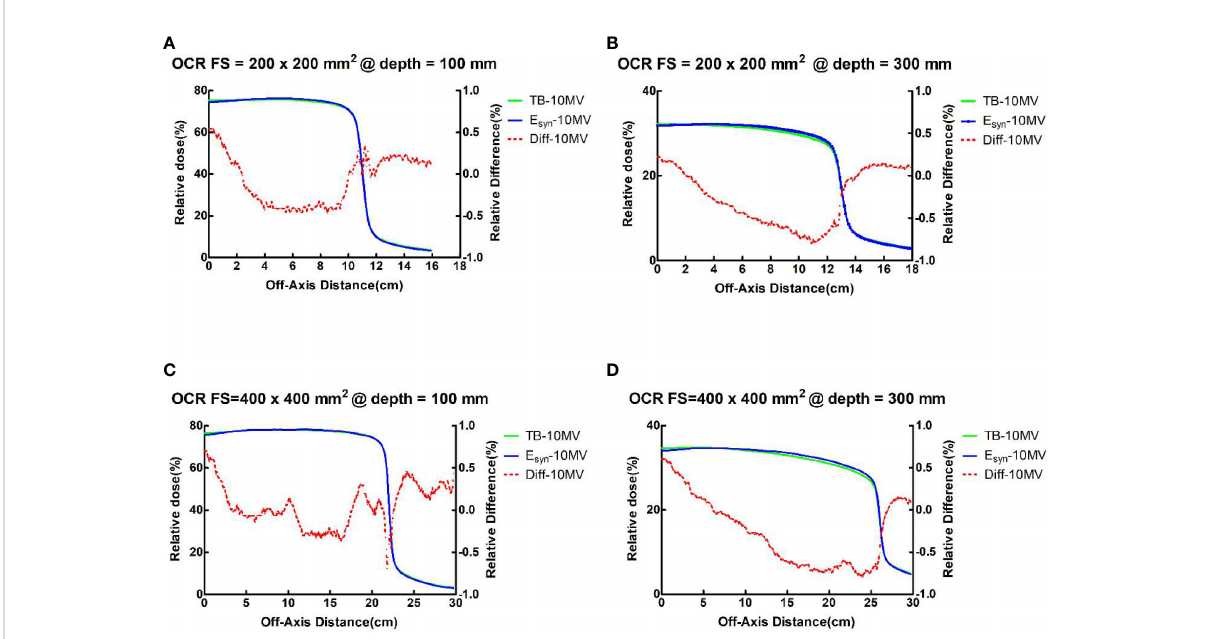
FIGURE 3 TB-10MV and E syn -10MV OCRs and differences for the 200 × 200 mm 2 fi eld size at depth = (A) 100mm and (B) 300mm, and for the 400 × 400 mm 2 fi eld size at depth of (C) 100mm and (D)